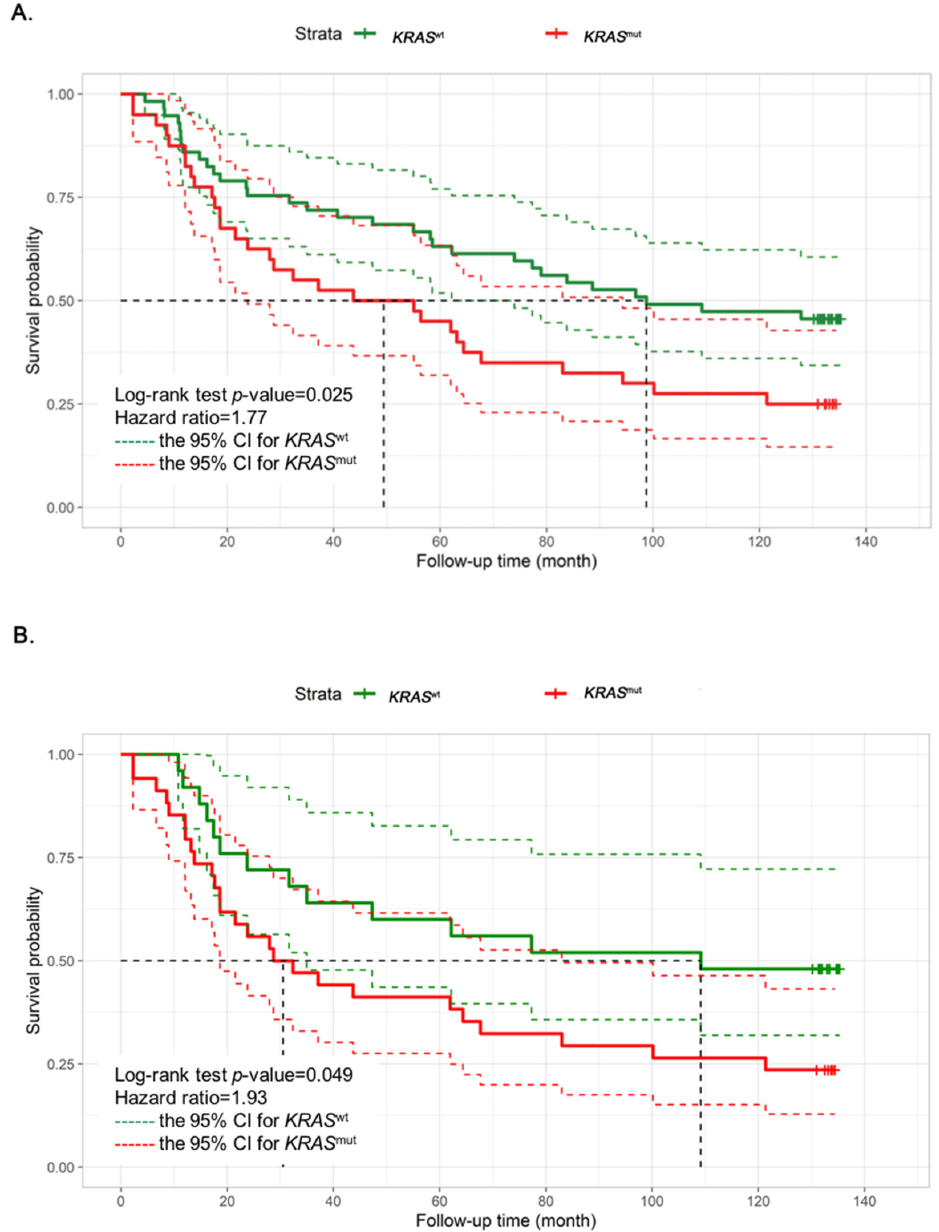
Figure 1. Kaplan–Meier graphs depicting overall survival (OS) of colorectal cancer patients according to the mutational status of KRAS in ( A ) all cohort ( n = 97) and ( B ) transcriptomic study cohort ( n = 59). Each graph shows univariate hazard ratios (95%CI) and log rank p -values. The dashed lines indicate the 95% CI for KRAS wt (in green dash) and KRAS mut (in red dash). KRAS wt , KRAS wild type; KRAS mut , KRAS mutation; CI, confidence interval.